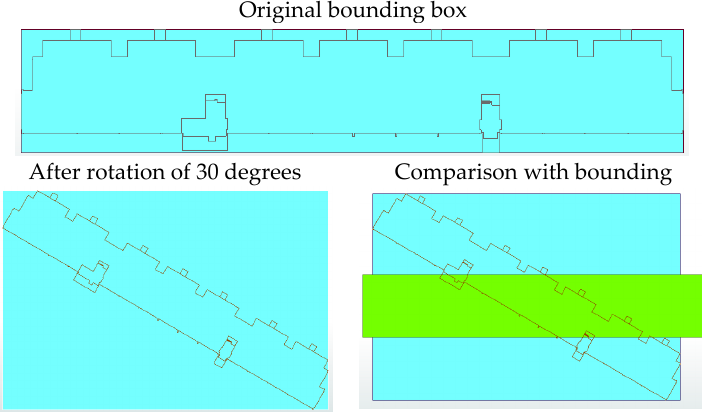
Figure 13. Bounding box of IFC model before and after 3D rotation.